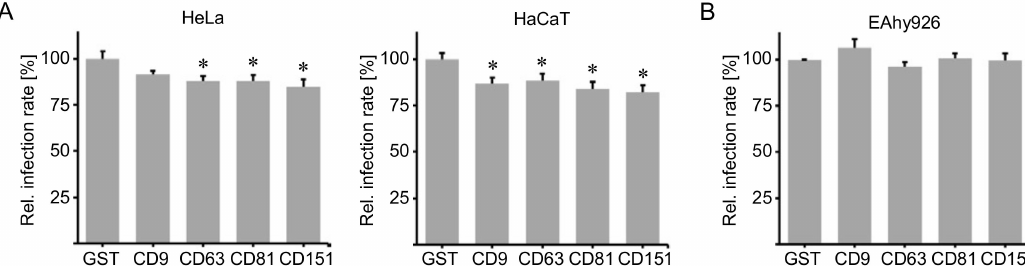
Figure 2. Peptides comprising the large extracellular loop of tetraspanins interfere with HPV16 infection. ( A ) HeLa and HaCaT cells were incubated with 500 nM glutathione S -transferase (GST) negative control protein or GST fusion proteins comprising the large extracellular loop of tetraspanin CD9, CD63, CD81 or CD151 for 3 h. Cells were infected with HPV16 PsVs and relative infection rate was assessed by measuring luciferase activity 24 h post infection (h.p.i.). ( B ) EA.hy926 cells were incubated with 500 nM GST negative control protein or GST fusion proteins of the large extracellular loop of tetraspanin CD9, CD63, CD81, or CD151 for 2 h. Cells were infected with HCMV strain TB40/E and analyzed via immunofluorescence. The fraction of infected cells was calculated by dividing the number of immediate early antigen (IE-Ag) positive cells by the number of DAPI positive nuclei 24 h.p.i. The data is shown as mean ± SEM and was normalized to the mean of control peptide (GST) treated cells (set to 100%). Asterisks indicate significant differences compared to control ( p <